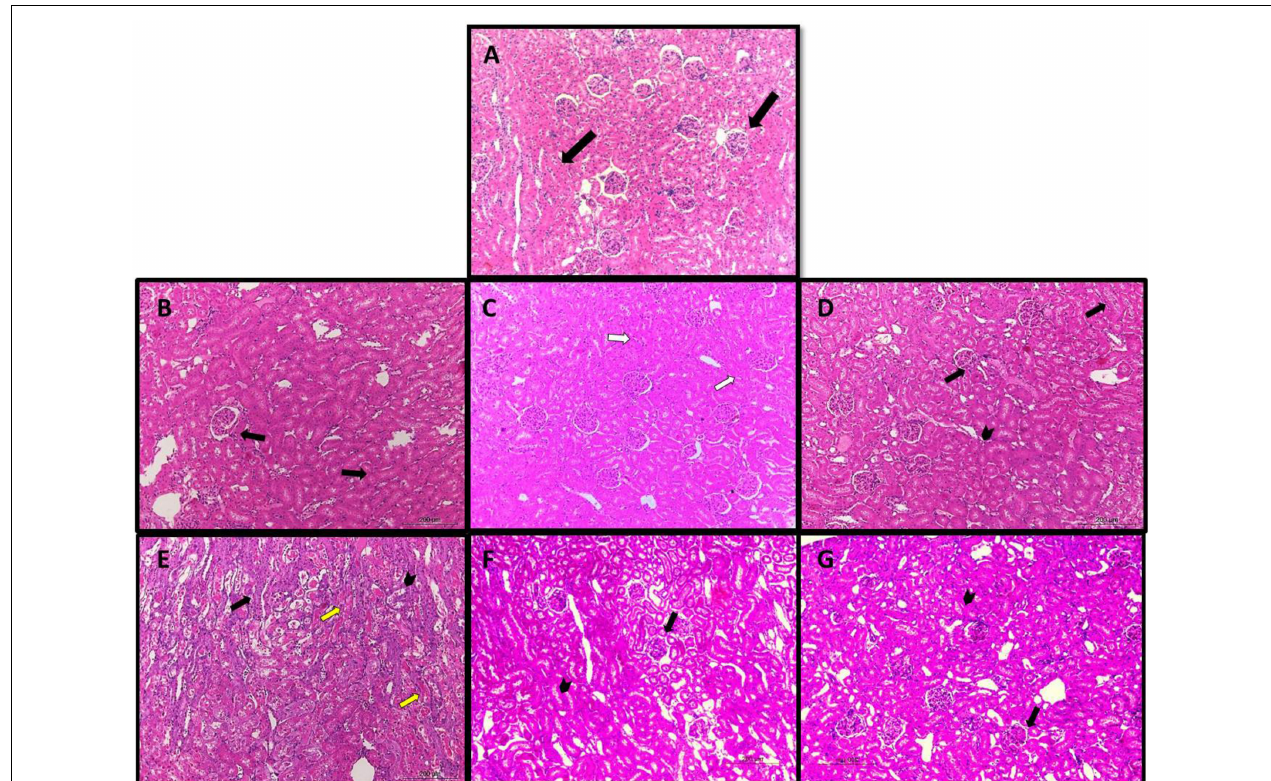
FIGURE 4 | Photomicrograph of kidney sections of (A) normal rats showed normal histologic structure of glomeruli and renal tubules (black arrow). (B) Cisplatin treated rats after 1 day showed more or less normal histological structure of renal glomeruli and lining epithelium lining the renal tubules (black arrows). (C) 2 days after injection of cisplatin showed mild degenerative changes of renal epithelial degeneration associated with mild desquamation of tubular epithelial cells (white arrows). (D) Cisplatin treated rats after 3 days showed moderate epithelial degeneration of lining epithelium Additionally, glomeruli tufft are suffering from mild to moderate glomerulonephrosis (black arrow). focal leukocytic infiltration could be detected in the interstitial area (black head). (E) Cisplatin after 4 days showed severe degenerative changes and necrosis associated with desquamation of renal lining epitheliums (yellow arrow). Moreover glomeruli tuft are suffering from severe degenerative changes (black arrow). (F) Rats treated with cisplatin for 4 days with rivaroxaban 5 mg/kg showed moderate degenerative changes of renal epithelium (arrow head) associated with glomerulonephrosis (arrow). (G) Rats treated with cisplatin for 4 days with rivaroxaban 7 mg/kg showed moderate degenerative changes of renal epithelium (arrow head) associated with mild glomerulonephrosis (arrow). (HE